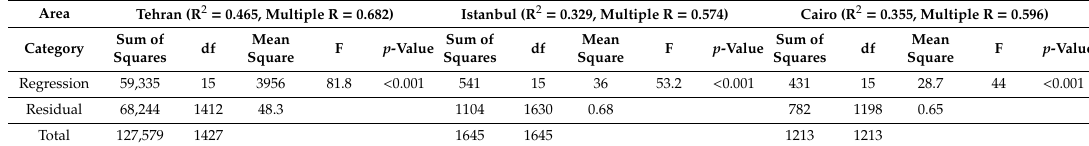
Figure 6. The β values of the significant variables (including marginally significant at 0.1 level) of the WLS models of Tehran, Istanbul, and Cairo (dependent variable: commute distance). Table 7. F-test results of WLS models of Tehran, Istanbul, and Cairo.